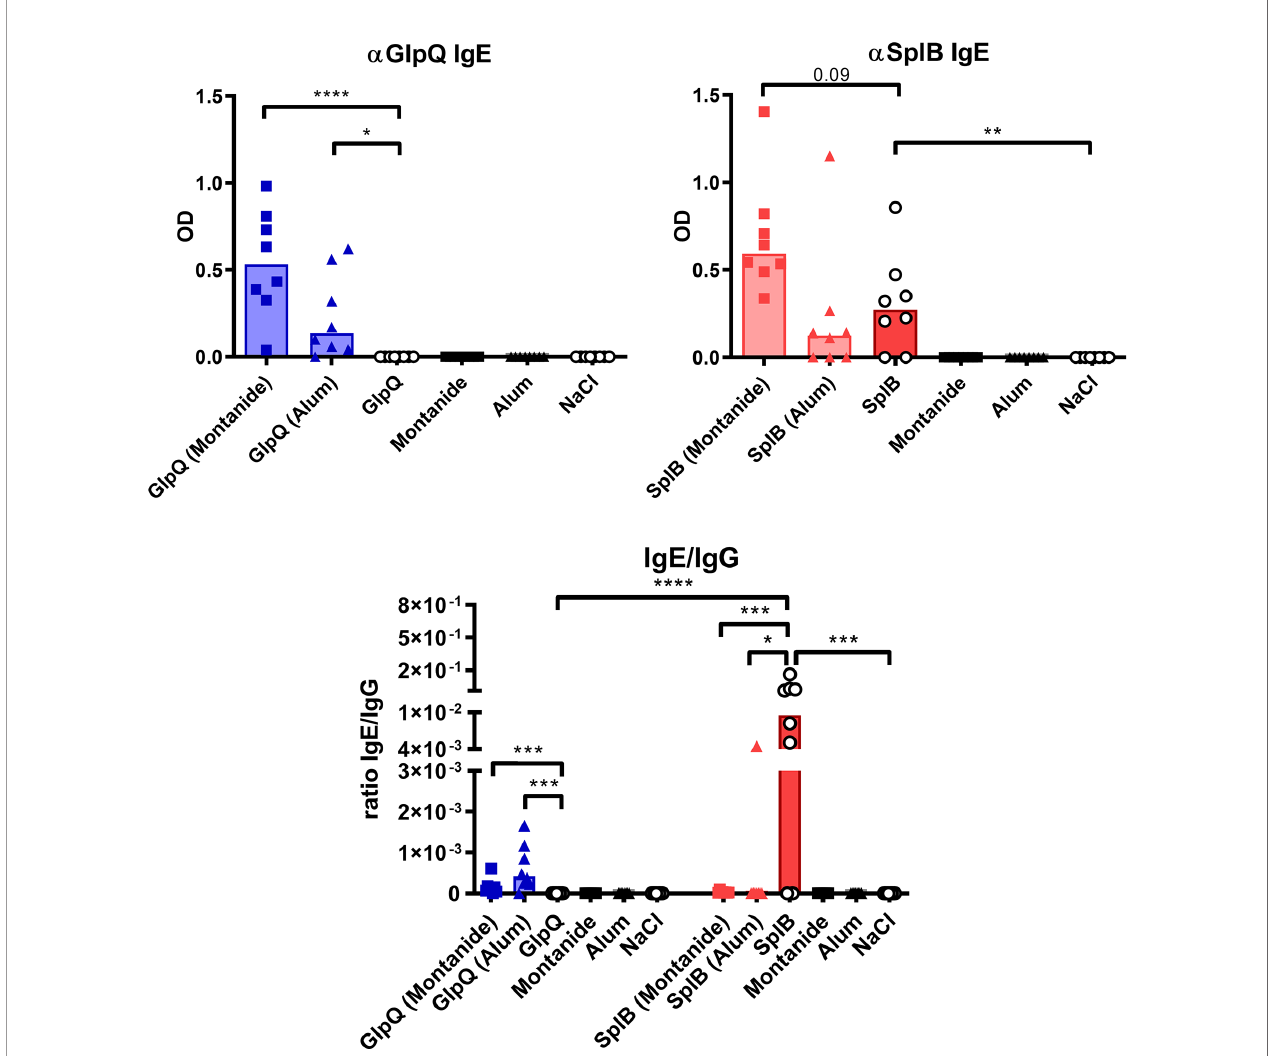
FIGURE 9 | Non-adjuvanted SplB induced IgE production and skewed the antibody response toward a type 2 pro fi le. Antigen-speci fi c IgE was measured in the serum 7 days after boost via ELISA and compared to the measured IgG response. Data are presented as median. n = 8 animals per group. OD: optical density. *p < 0.05; **p < 0.01; ***p < 0.001; ****p < 0.0001. Group comparisons that are de fi ned in the “ Statistical analysis ” section but not shown here are not signi fi